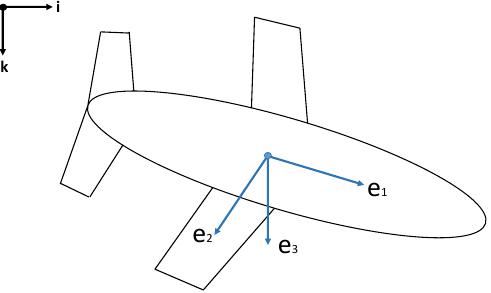
Figure 14. Coordinate system for the underwater